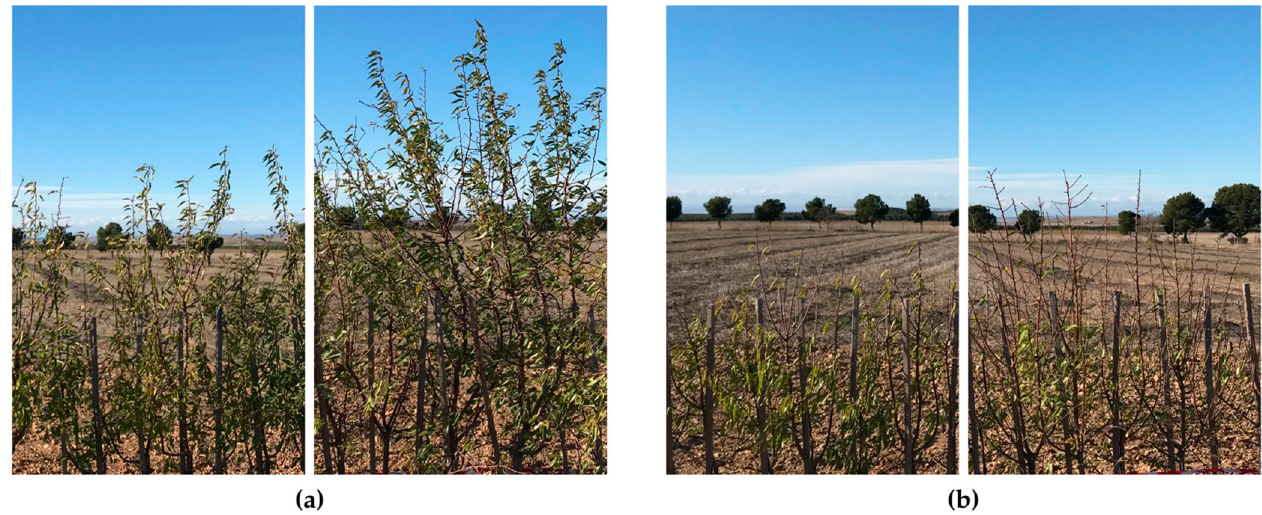
Figure 1. Scion–rootstock combinations of 2-year-old almond trees show low and high vigor responses: ( a ) ‘Guara’ and ( b ) ‘Diamar’ grafted onto ‘GN-8’ ( left ) and ‘Garnem’ ( right ) rootstocks, respectively. Table 1. Parameters used to quantify aspects of almond tree architecture and the corresponding formula if parameters were calculated from other traits. Data were measured on the primary growth axis (trunk) or axillary branches of 2-year-old almond trees for 30 scion–rootstock combinations.